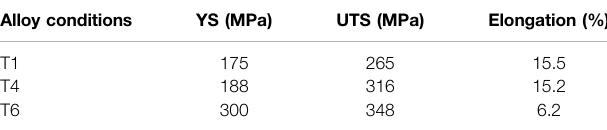
TABLE 1 | Mechanical properties of the alloy in different conditions.